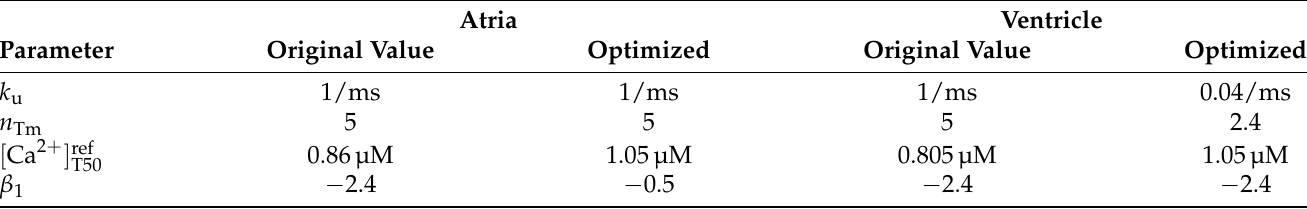
Table 7. Optimized parameters for the atrial and ventricular tension development model. The original values are taken from [34,72]. Values not listed in this table are unchanged from the original